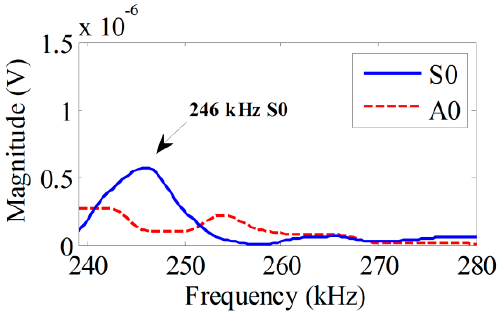
Figure 5. The S0 mode modulation is generated at 468 kHz only when the nonzero power flux and synchronism condition are matched (both primary waves at 195 kHz and 273 kHz are S0 mode): ( a ) No modulation at 78 kHz; ( b ) S0 at 468 kHz.